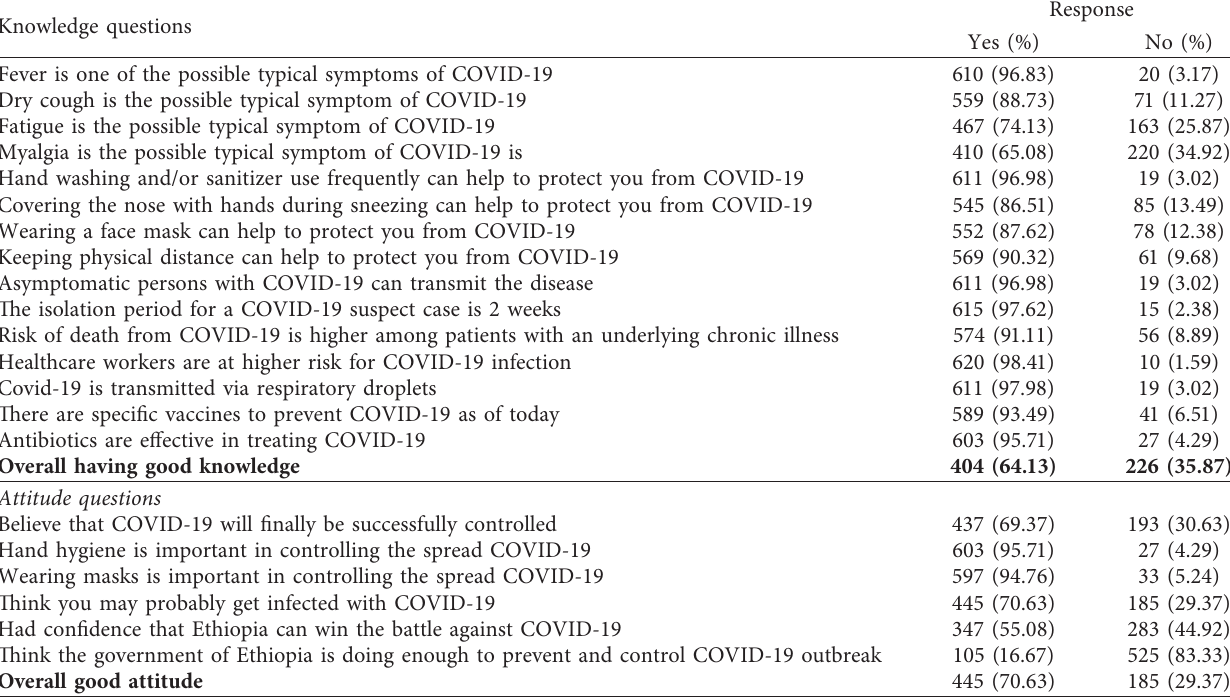
Table 2: Descriptive statistics of knowledge and attitude of HCWs towards